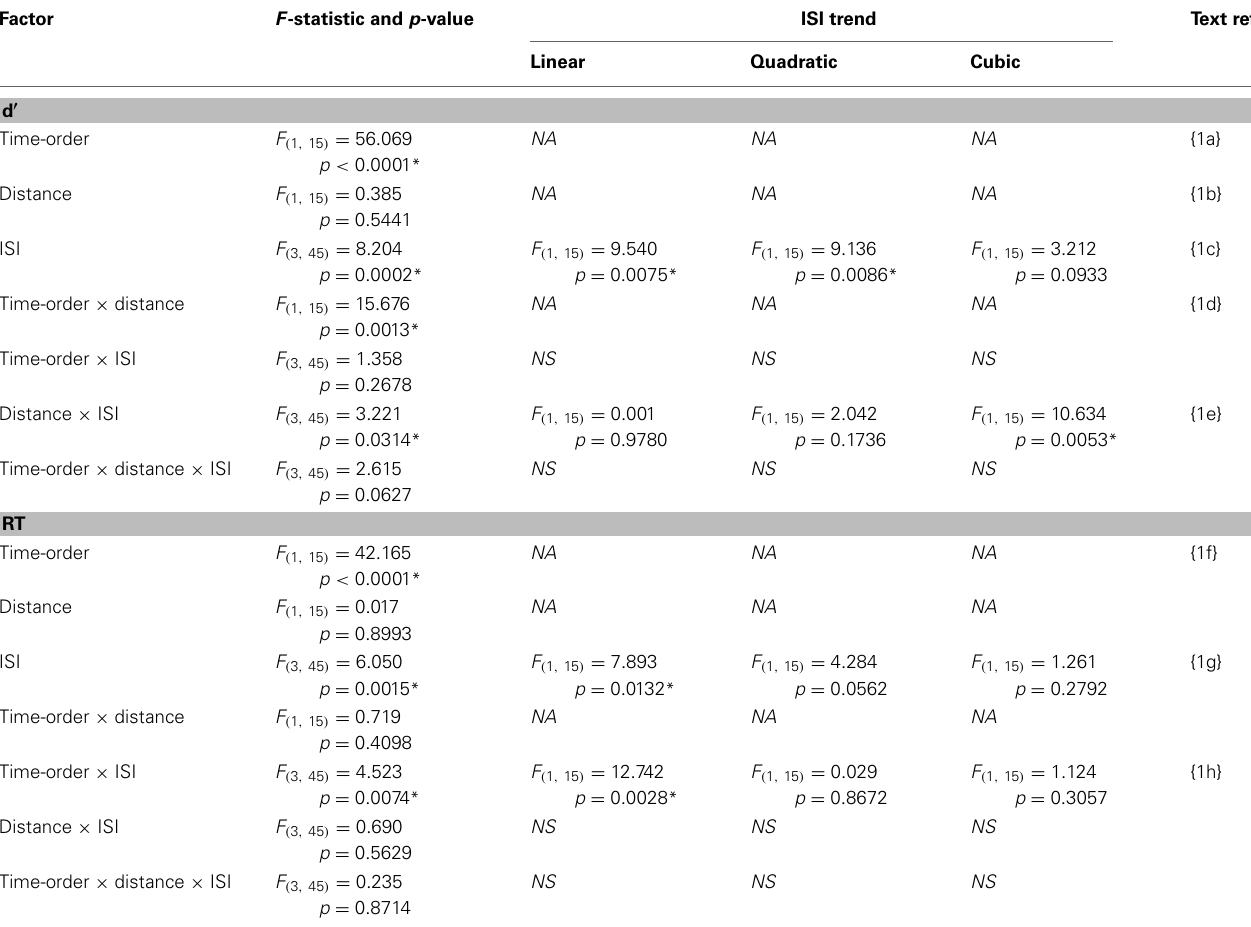
Table 1 | Experiment 1 accuracy (d (cid:2) ) and response time (RT) statistics of the time-order × distance × ISI repeated measures ANOVA. Factor F -statistic and p -value ISI trend Text ref. Linear Quadratic